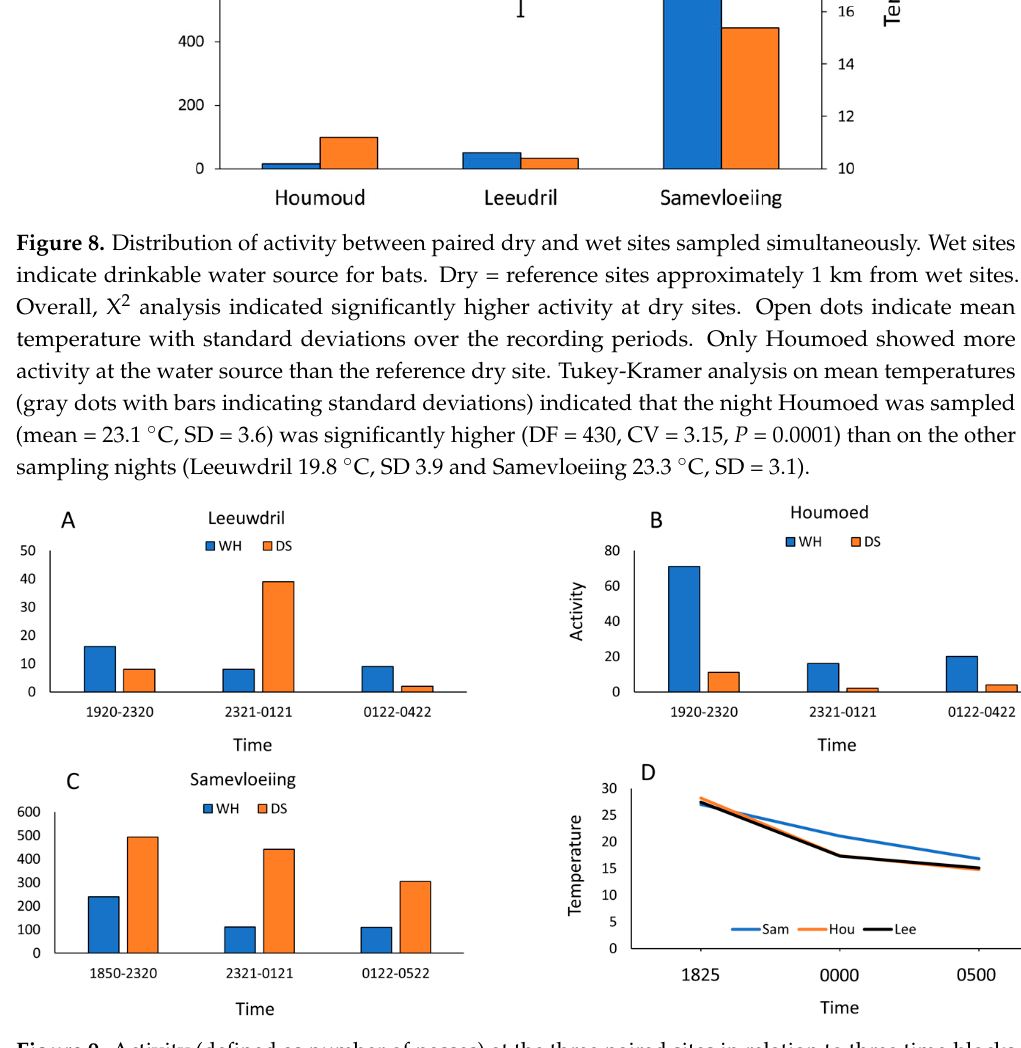
Figure 9. Activity (defined as number of passes) at the three paired sites in relation to three time-blocks representing activity periods (1850–2320 h, 2321–0121 h, and 0122–0522 h) ( A ) Leeuwdril (13 April 2016), ( B ) Houmoed (4 April 2016), and ( C ) Samevloeiing (11 April 2016). Blue = water sources and Orange = dry sites. Most activity at water sources was consistently higher in the earliest time blocks, whereas activity was more variable at dry sites but generally increased between sunset and 2200 h. ( D ) Mean changes in temperature from sunset to sunrise during the sampling periods showed declines over the sampling periods, with Leeuwdril and Houmoed showing steepest and nearly identical declines. Samevloeiing showed a more gradual temperature decline throughout the night.